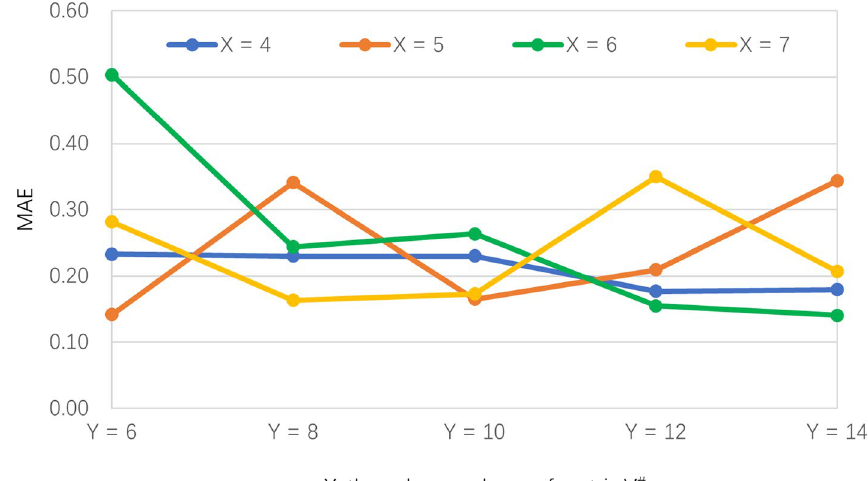
Fig. 5 MAE of FSPLO w.r.t. ( X , Y )